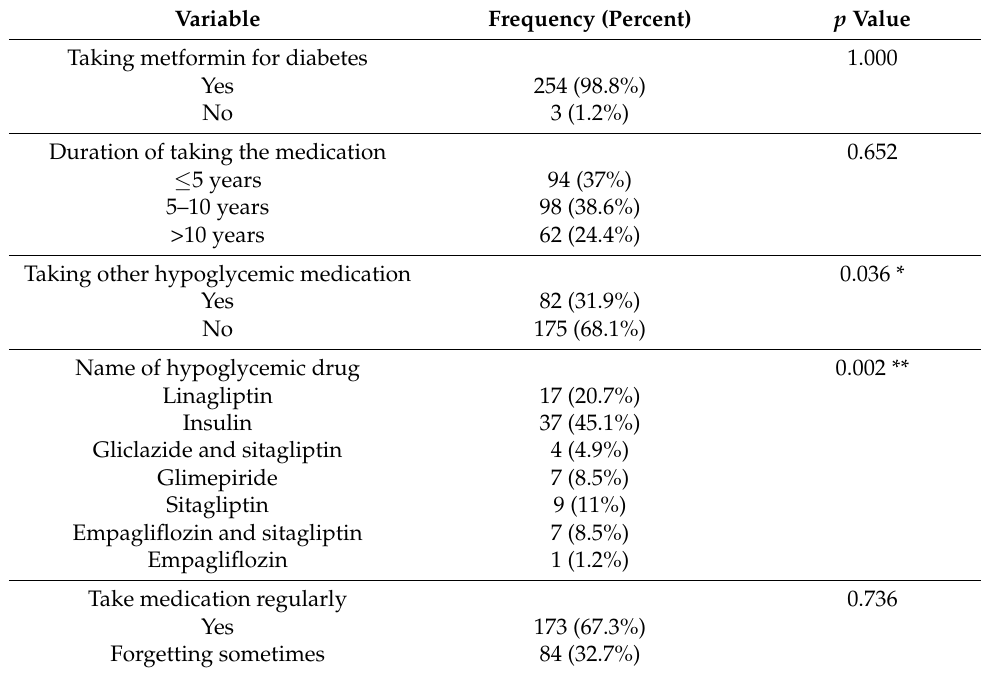
Table 2. Medication information ( n = 257).